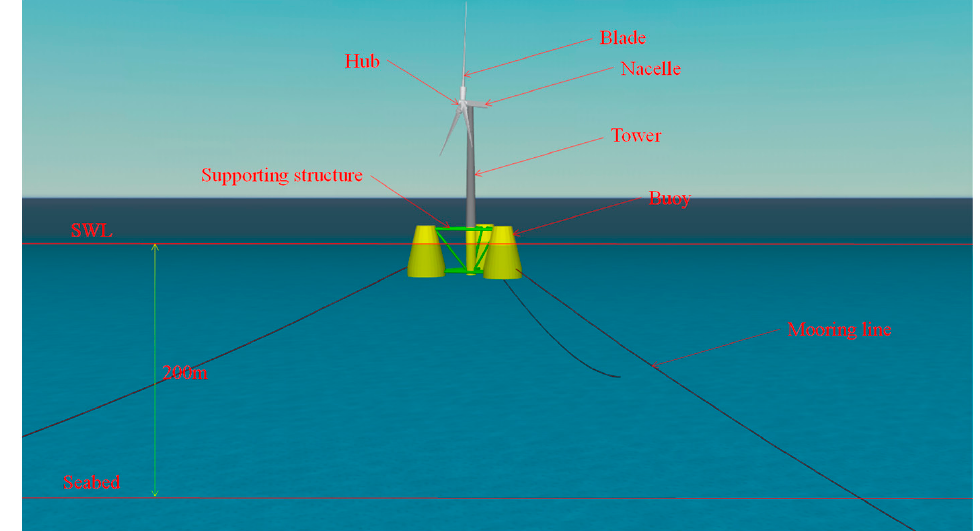
Figure 1. The original floating wind turbine.